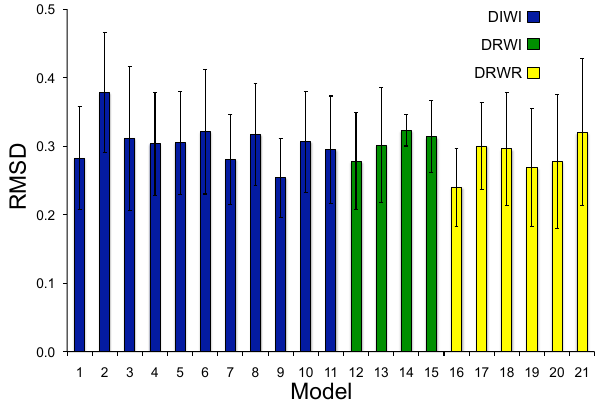
Fig. 5. Reduction in RMSD at each region based on uncertainties in individual input parameters, all input parameters, NPP measure- ments, and both the input parameters and NPP measurements. Val- ues in parentheses are mean reductions in RMSD across all regions.